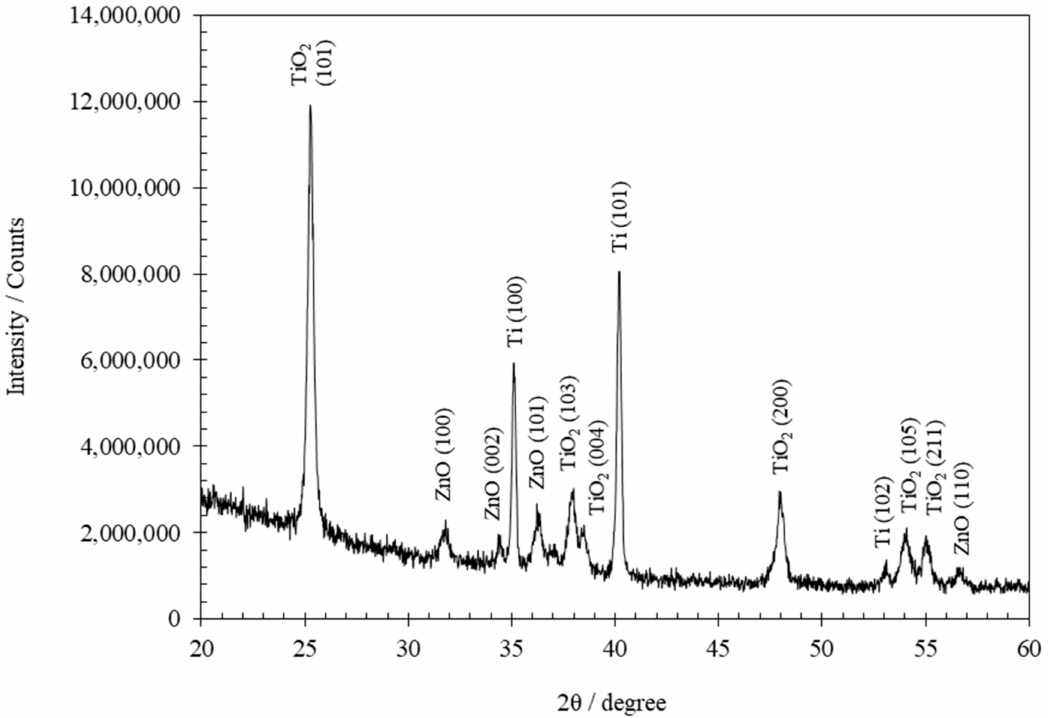
Figure 10. GIXRD pattern of the TiO 2 /ZnO hybrid nanosponges electrodeposited for 15 min at 75 ◦ C with 10 mM Zn(NO 3 ) 2 after the heat